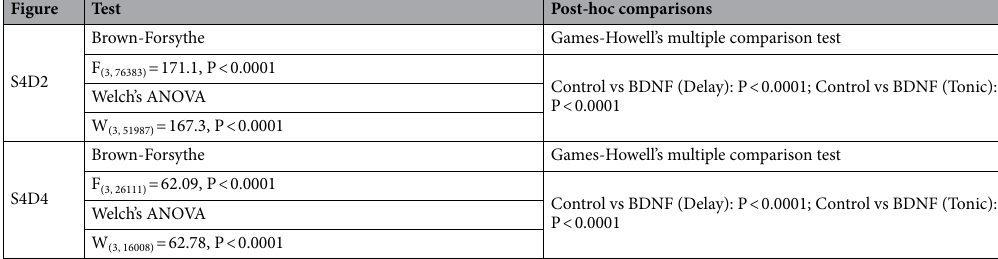
Table 1. Detailed results of statistical analysis per figure.